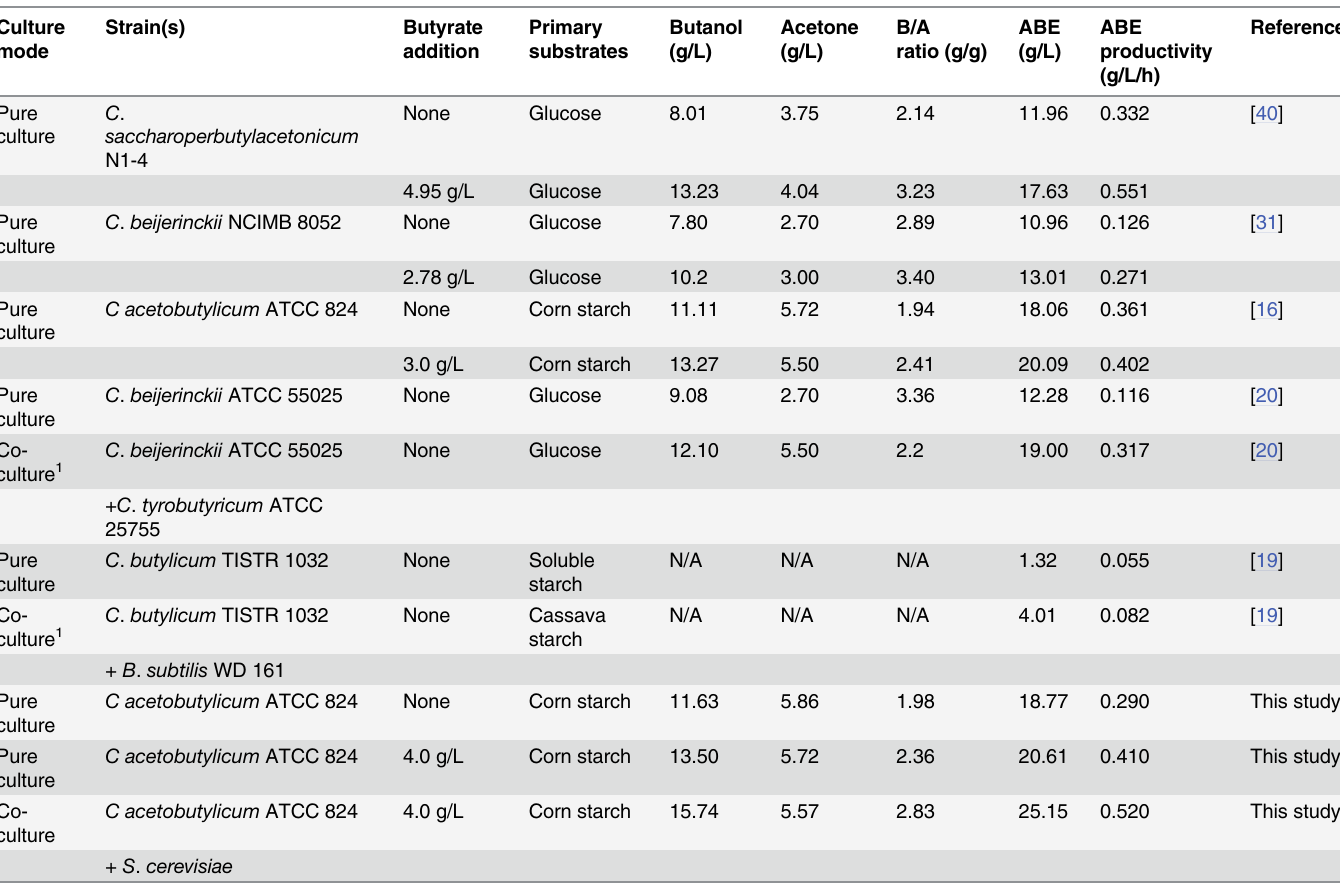
Table 2. Performance comparisons of ABE fermentations by butyrate supplementing or/and various co-culturing systems. Culture